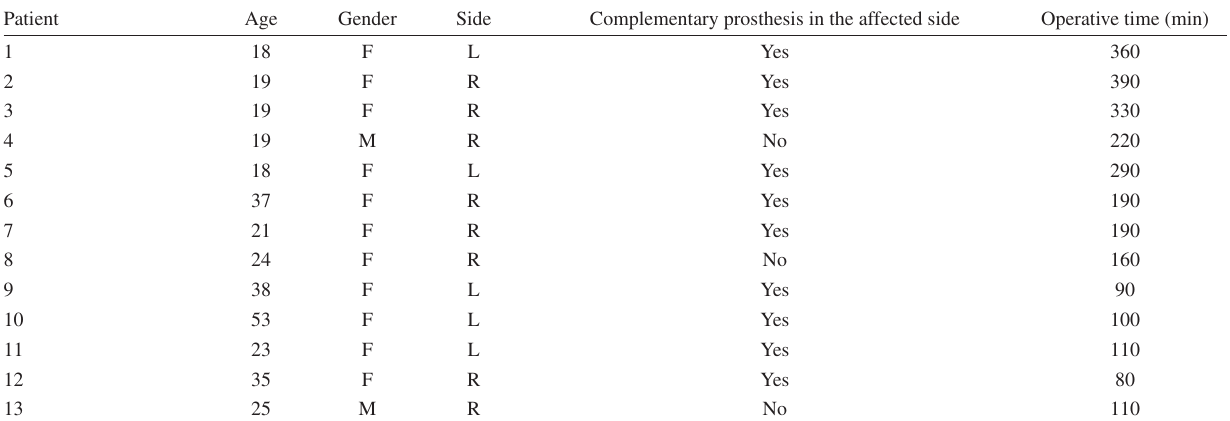
Table 1 - Clinical and surgical characteristics of patients with Poland’s syndrome in chronological order of their treatment.